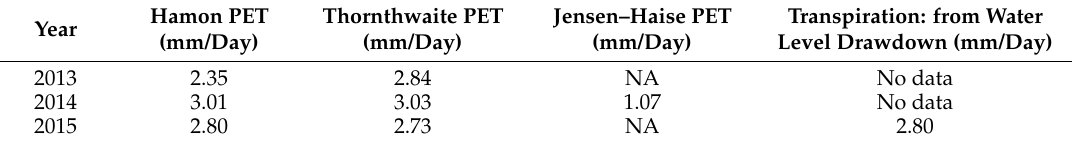
Table 7. Average potential evapotranspiration and transpiration per day during the monitoring period. Water level drawdown was estimated for a time period when water was in the shallow root zone (upper 1 m) with no ponding.